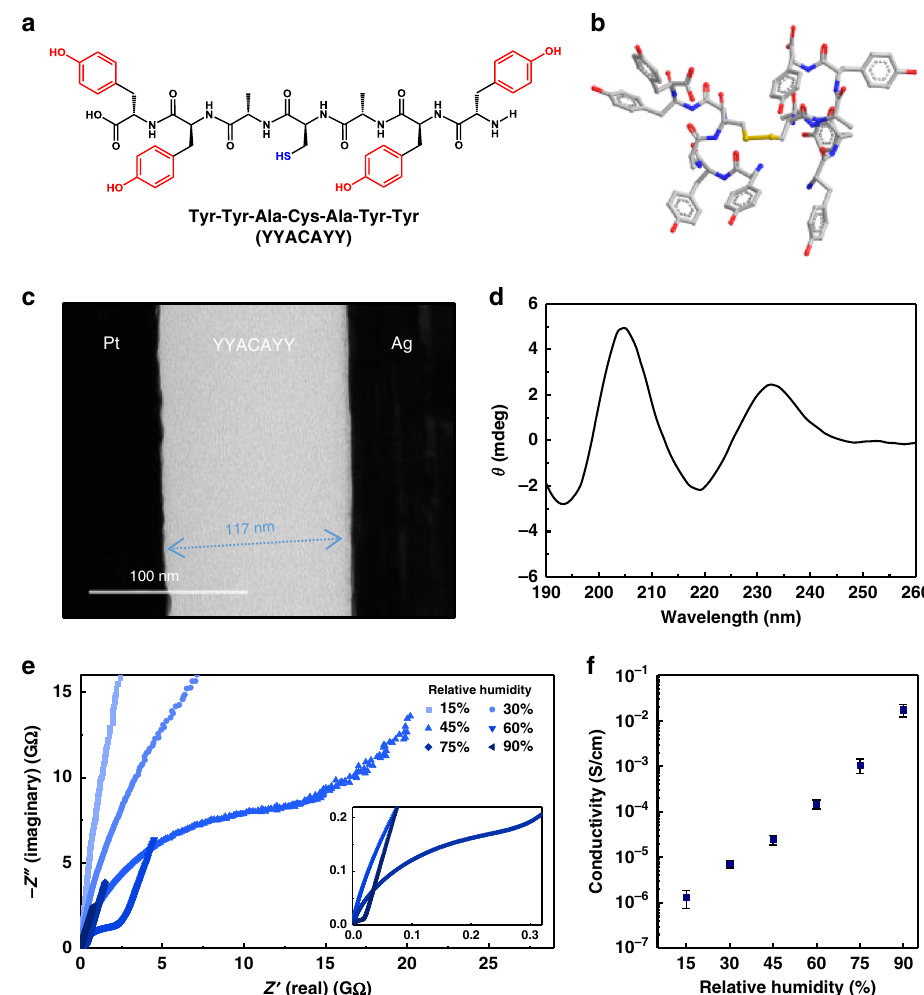
Fig. 1 Film formation and proton conduction of the Y7C peptide. ( a ) Chemical structure of the Y7C peptide. The phenolic groups of tyrosine and thiol groups of cysteine are highlighted in red and blue, respectively. ( b ) Molecular structure of the dimer of Y7C revealed by NMR. Carbon, oxygen, and nitrogen are shown in gray, red, and purple, respectively. ( c ) Cross-sectional HRTEM image of the Y7C fi lm between Pt and Ag electrodes. A uniform and homogeneous fi lm with a thickness of 117 nm can be identi fi ed between the Pt bottom electrode and the Ag top electrode. ( d ) Circular dichroism (CD) analysis of the Y7C fi lm. The solid CD spectrum is expressed in degrees of ellipticity ( θ ) without concentration terms. ( e ) Nyquist plots measured from the Y7C fi lm in contact with two Au electrodes at different RH. The inset shows the magni fi ed range at RH values of 60%, 75%, and 90%. ( f ) Conductivity of the Y7C fi lm calculated from the Nyquist plot as a function of RH. Error bars represent the mean ±